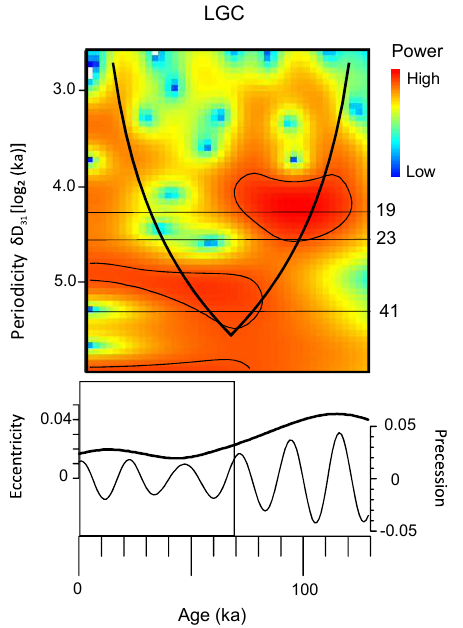
Figure 7. Spectral analysis of hydrogen ( δ D 31 ) isotope composi- tions of the C 31 n alkane (from Kuechler et al., 2013) using a Mor- let wavelet for the last glacial cycle (LGC). Data are interpolated to 3kyr steps. Signal power is expressed in colour shadings with the significance level ( p = 0 . 05) in black contours. The cone of in- fluence (thick black line) identifies the area of boundary effects. Periodicities per thousand years on the vertical axes (log 2 scale). Horizontal lines denote orbital periodicities of 19 and 23kyr (pre- cession), and 41kyr (obliquity). Bottom: eccentricity and preces- sion for the same period. The box indicates the period with reduced eccentricity and low precession